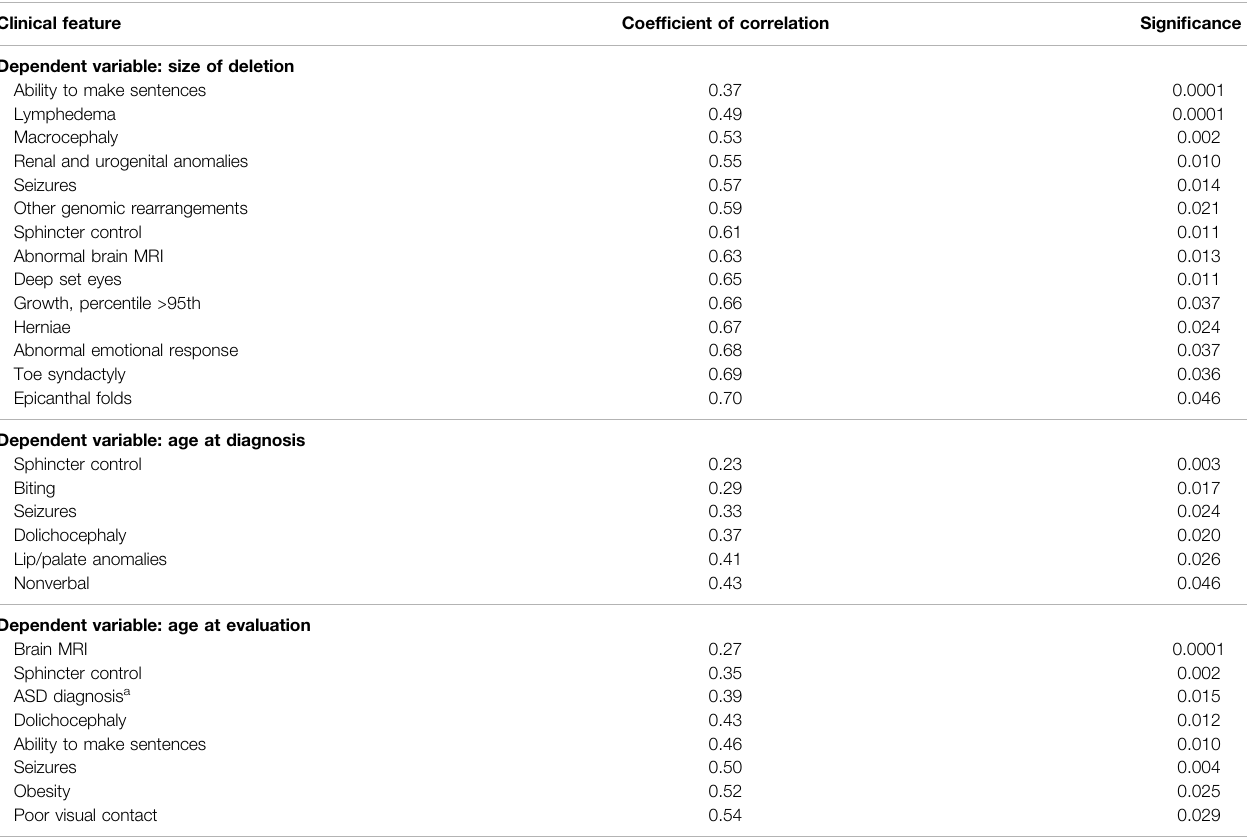
TABLE 7 | Comparison of clinical features and the size of the 22q13 deletion, age at diagnosis and age at evaluation using linear regression to obtain a coef fi cient of correlation. Clinical